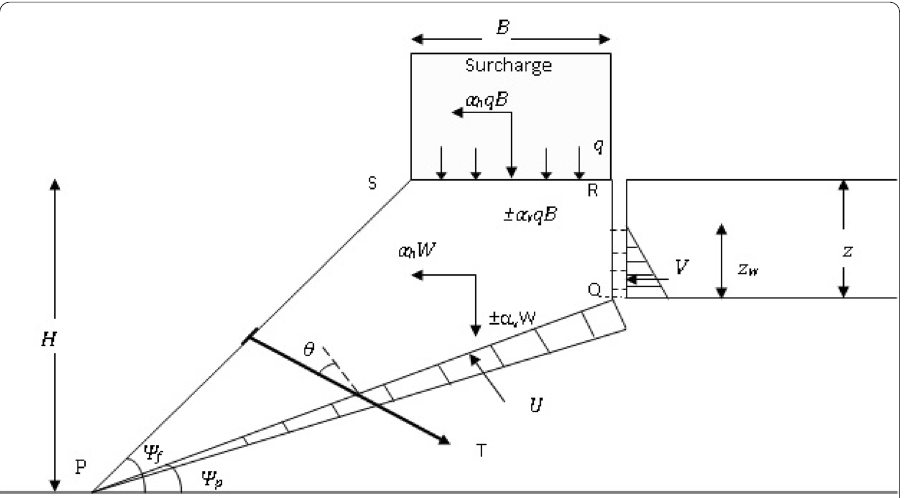
Fig. 1 An anchored rock slope section with tension crack partially filled with water and all the forces acting on the